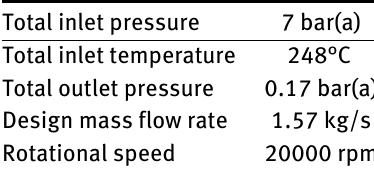
Table 2: Design parameters of the centrifugal